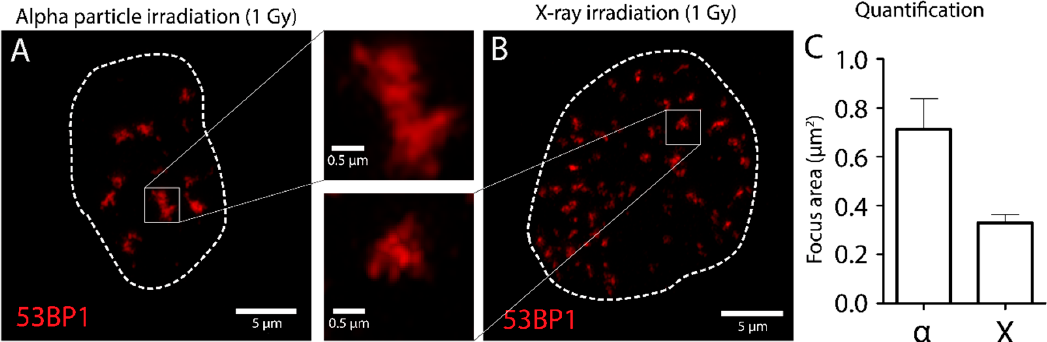
Figure 5. Nanoscopic analysis of DSBs in U2OS cells. U2OS are irradiated using external alpha particle irradiation ( A ) or X-ray ( B ), fixed after 1 h and stained for 53BP1 as DSB marker. SIM imaging was used for nanoscopic analysis of 53BP1 foci. Foci were quantified using ImageJ ( C ). Enlarged figures show 53BP1 foci in close up.